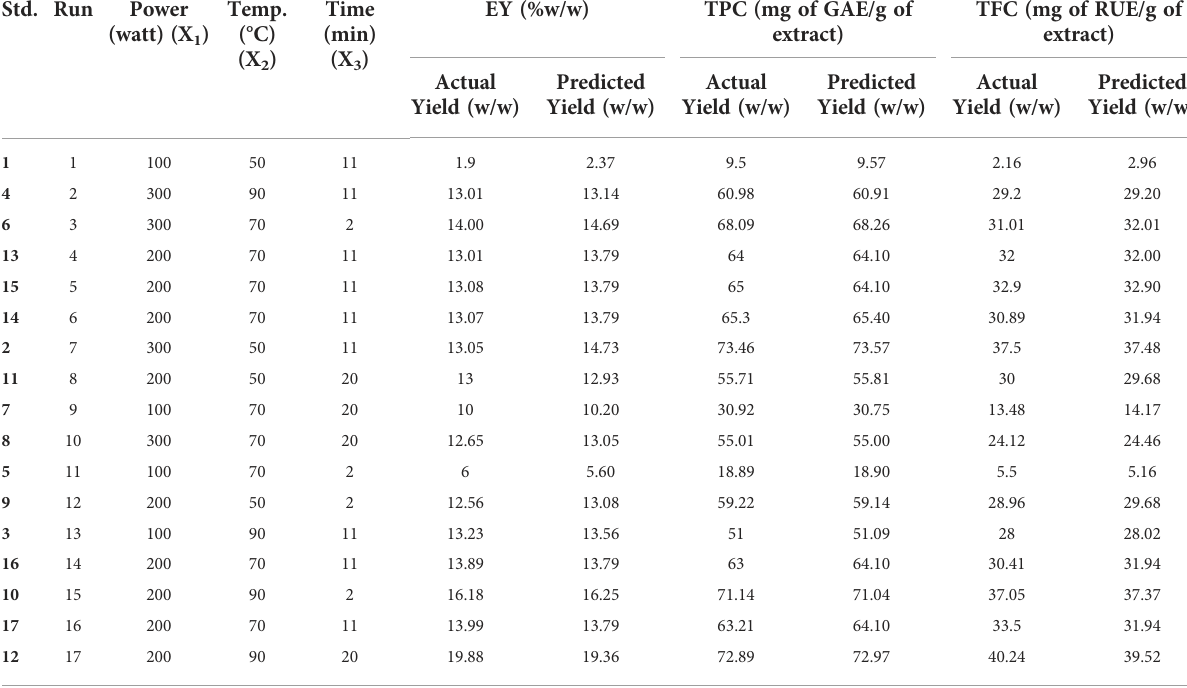
TABLE 2 Actual and Predicted values for extraction yield, TPC and TFC for different parameters (MAE). Std.